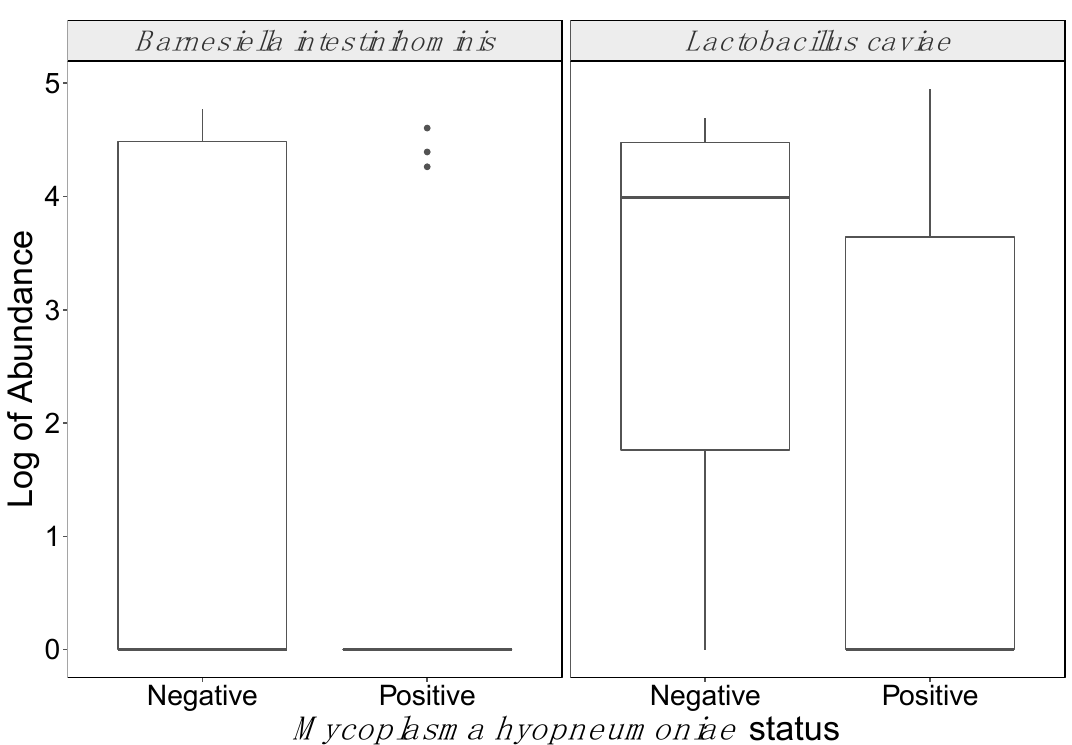
Figure 4. Amplicon sequence variants differentially abundant in fecal samples according to Mycoplasma hyopneumoniae status of paired tracheal fluid samples. Real-time PCR in tracheal samples was used to establish M. hyopneumoniae status. The heterogeneity in the proportions of the tracheal fluid microbial community po- tentially originating from fecal, air, or oral fluids sources is depicted in Figure 5. The characteristics of the distribution of the estimated proportions of ASVs by source are shown in Table 4. There was no statistical evidence that the distribution of the proportions of ASVs potentially originating from each microbial community differed according to